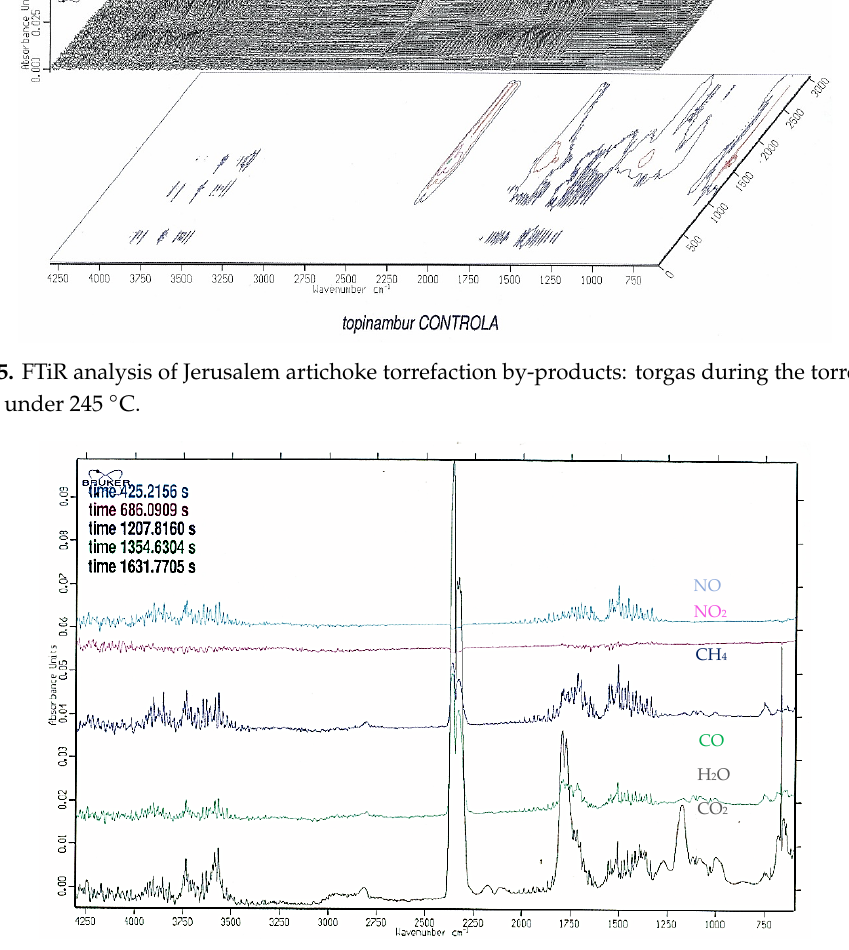
Figure 6. FTiR analysis of Jerusalem artichoke torrefaction by-products: torgas during the torrefaction process under 245 °C.